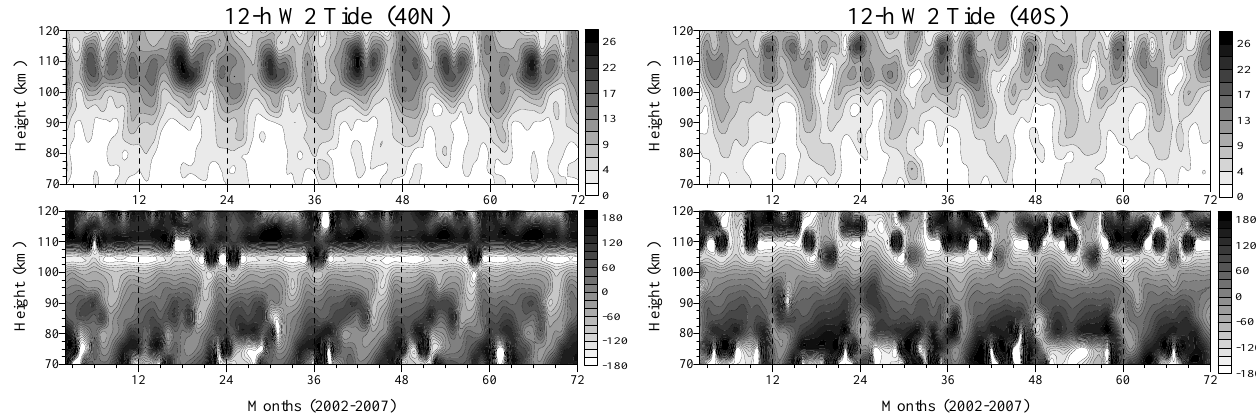
Fig. 2. Altitude-time cross sections of the tidal amplitudes in Kelvin (upper row of plots) and phases in degrees (bottom row of plots) Figure 2 observed at 40 ◦ N (left column of plots) and 40 ◦ S (right column of